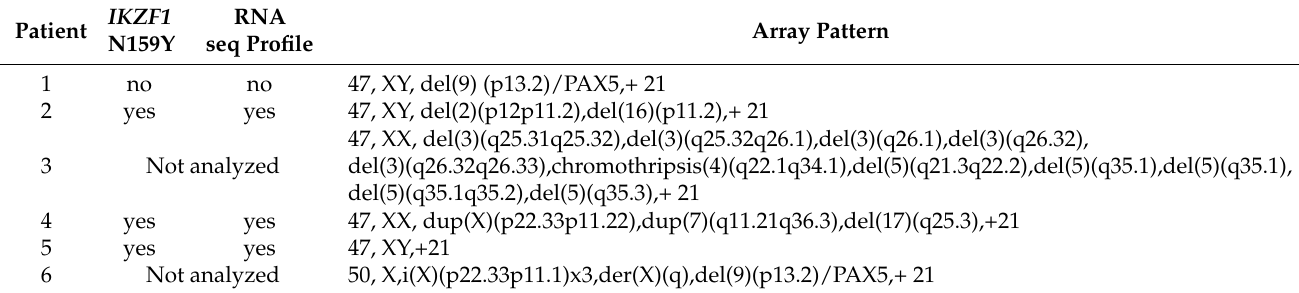
Table 2. Array patterns of six B-other cases with a solitary trisomy 21. Three of the four investigated cases had an IKZF1 N159Y mutation and the associated distinct expression pattern. The mutation was validated with PCR and the